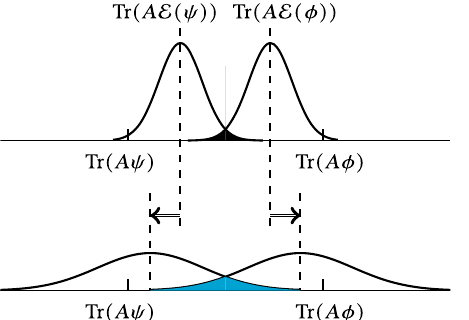
Fig. 7 Error mitigation and distinguishability. The top schematic illustrates the probability distribution of an observable A for two noisy states Eð ψ Þ and Eð ϕ Þ . The expectation values are shifted from the true values due to the noise effects. As in the bottom schematic, error mitigation converts them to other distributions whose expectation values are closer to the true values than the initial noisy distributions are. However, the converted distributions get broader, and the overlap between two distributions increases in